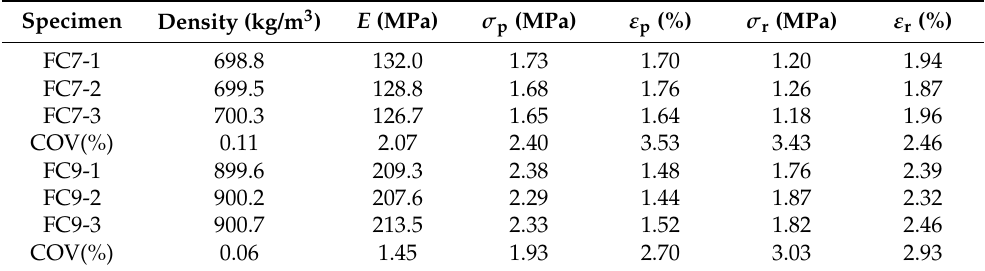
Table 1. Mechanical and physical properties of